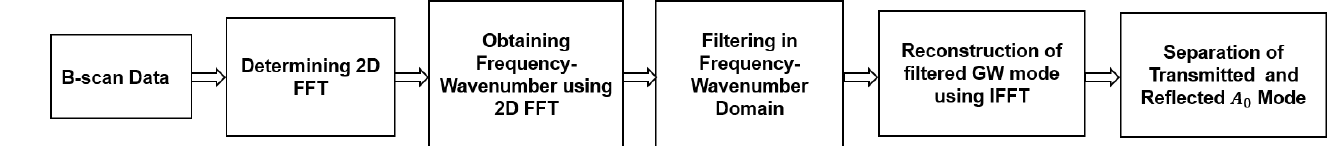
Figure 12. The implementation of the signal processing method for mode separation.